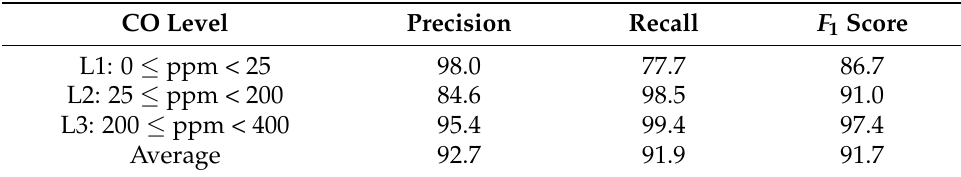
Table 3. Precision, recall and F 1 measure for classifying CO levels through HR. CO